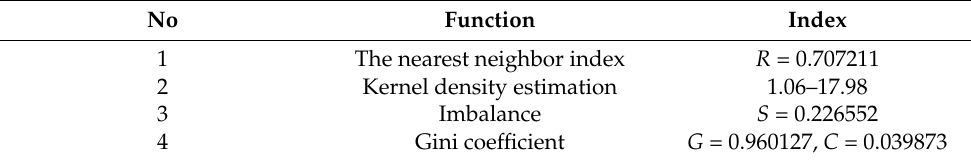
Table 7. Spatial index of beautiful leisure villages in China, calculated based on functions. No